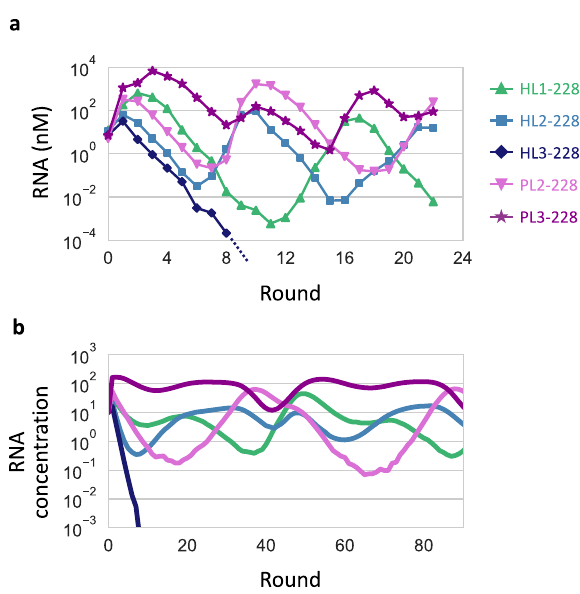
Fig. 5 Co-replication dynamics of the evolved RNA clones. a RNA concentration changes in a long-term replication experiment started with 10 nM each of the fi ve RNA clones at round 228, measured by sequence- speci fi c RT-qPCR. b Representative RNA concentration changes in a simulated long-term replication using the theoretical model. The replication rates of the simulated RNAs were based on those of the RNA clones of the same colors in ( a